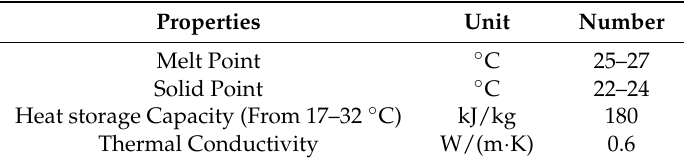
Table 2. Material properties of the PCM.